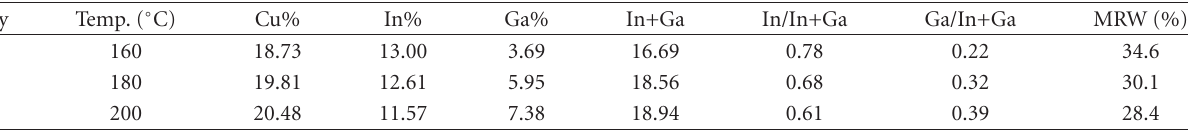
Table 2: Composition (from ICP-OES analysis) of soluble CuIn x Ga 1 − x S 2 nanoparticles prepared at 160, 180, or 200 ◦ C. Entry Temp. ( ◦ C)